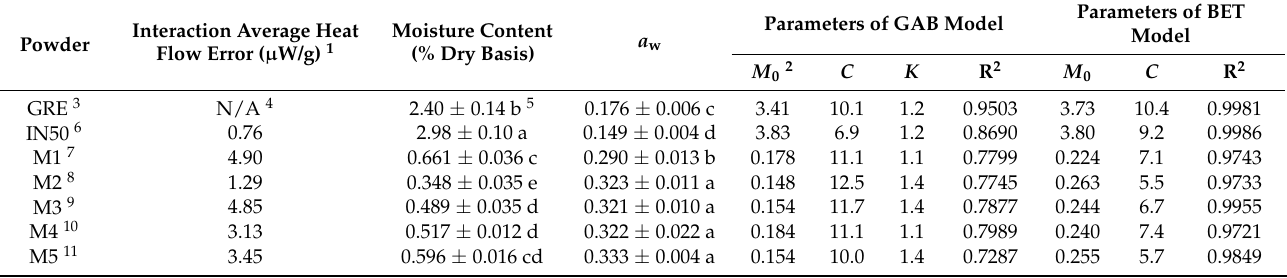
Table 1. Moisture content, water activity ( a w ) and parameters for Guggenheim–Andersonde Boer (GAB) and Brunauer– Emmet–Teller (BET) models fitted to moisture adsorption data obtained at 25 ◦ C for green rooibos extract powder and powder